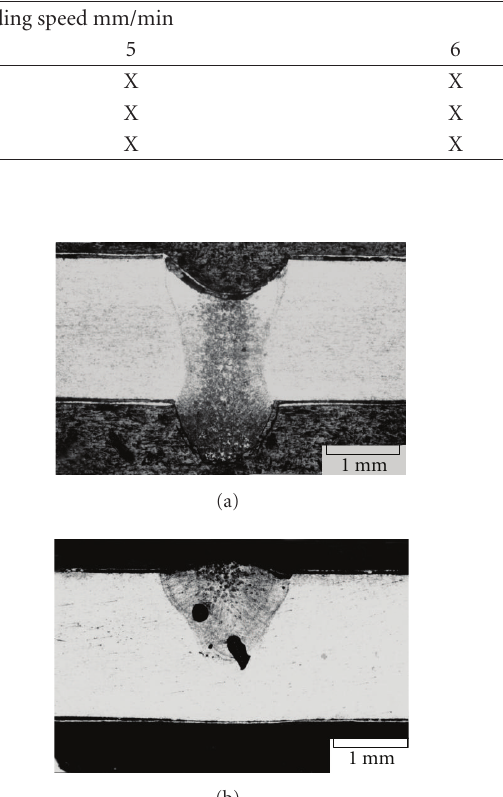
Table 3: E ff ect of welding speed on cracking of welded joints made without backing strip.